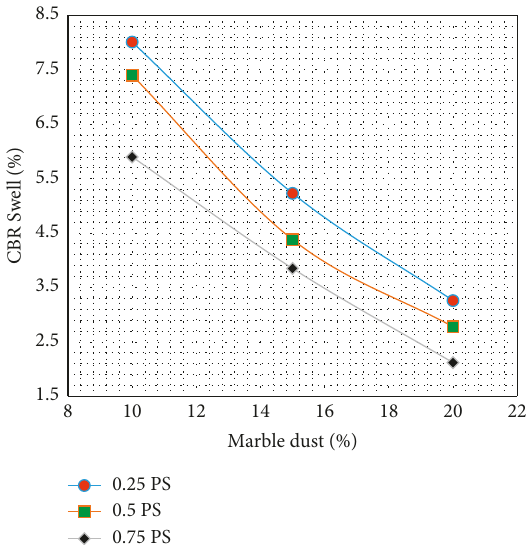
Figure 7: CBR swell variation with percentages of plastic strips and marble